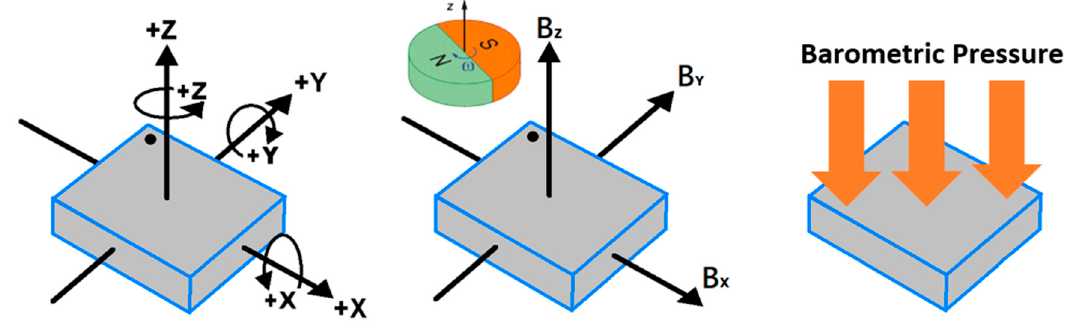
Figure 7. The gyro sensor, hall magnetic sensor, and barometric pressure sensor.